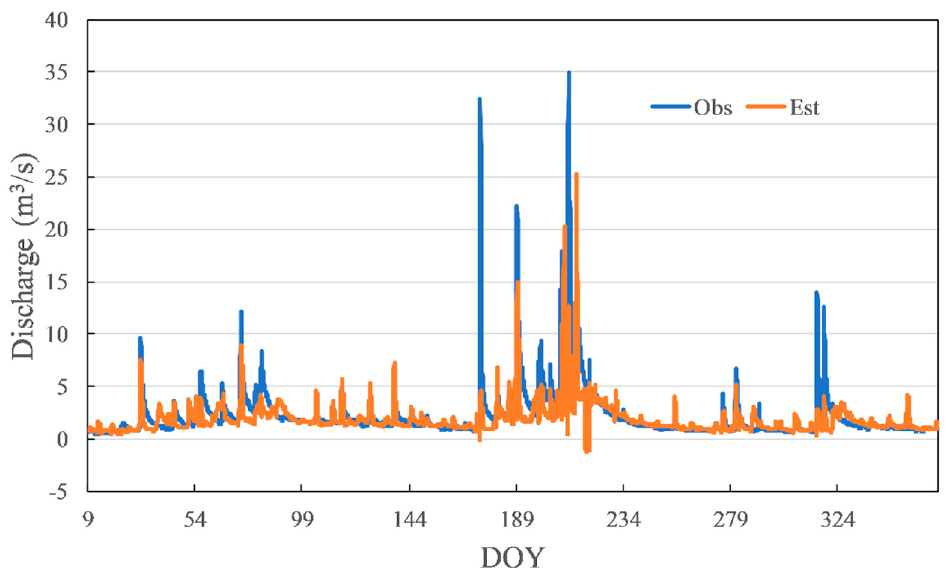
Figure 7. Hydrograph of Training No. 3.